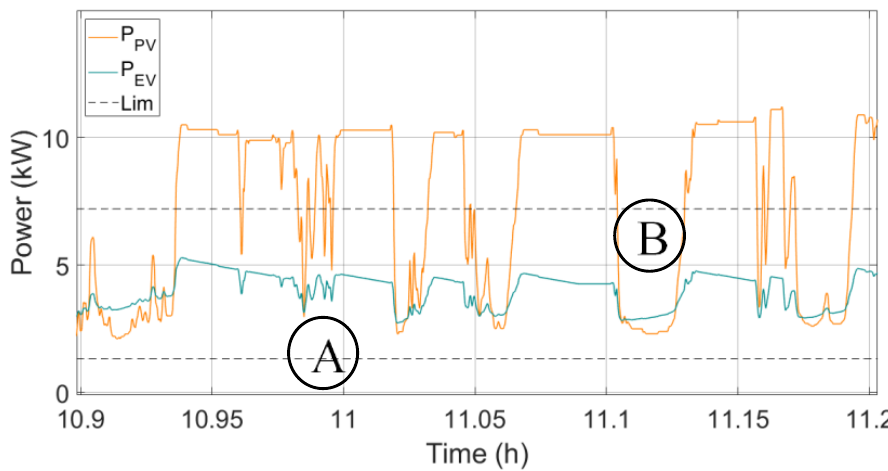
Figure 6. Photovoltaic power and charging power of an electric vehicle.